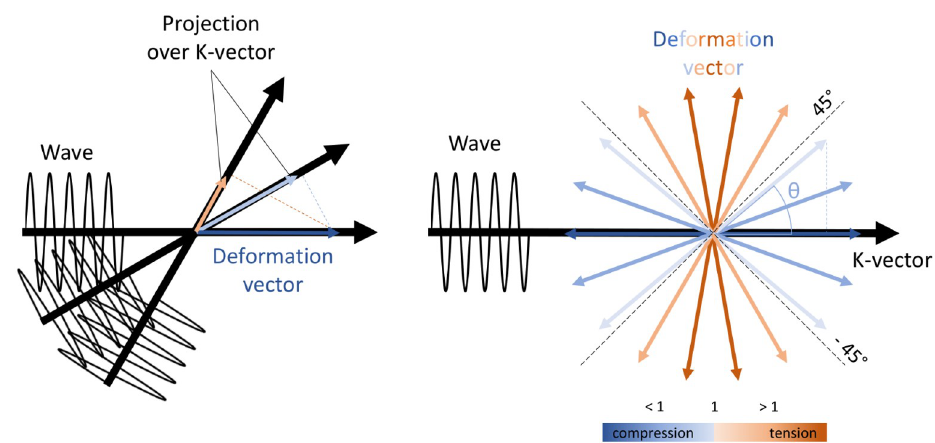
Fig 5. A new metric to account for the local deformation probed by the shear waves. Left: shear waves probe the material shear modulus along their direction of propagation, identified by the k-vector. Intuitively, this is comparable to the projection of the deformation field generated by the macro-deformation onto the k-vector. Right: for a spherical deformation, the angle between the deformation vector and the k-vector determines the magnitude of the probed material displacement and allows to differentiate between compression and